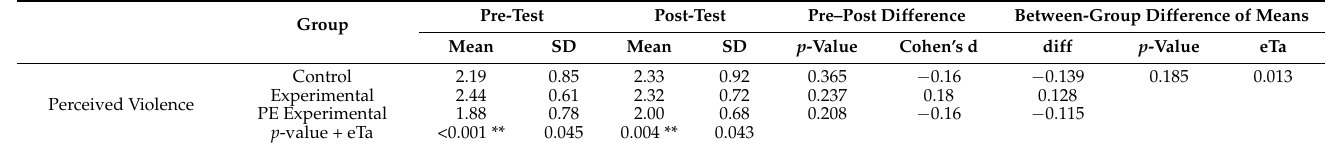
Table 9. Resilience, social school climate, prosocial behaviour, and perceived violence results. Group Pre-Test Post-Test Pre–Post Difference Between-Group Difference of Means Mean SD Mean SD p -Value Cohen’s d eTa Perceived Violence